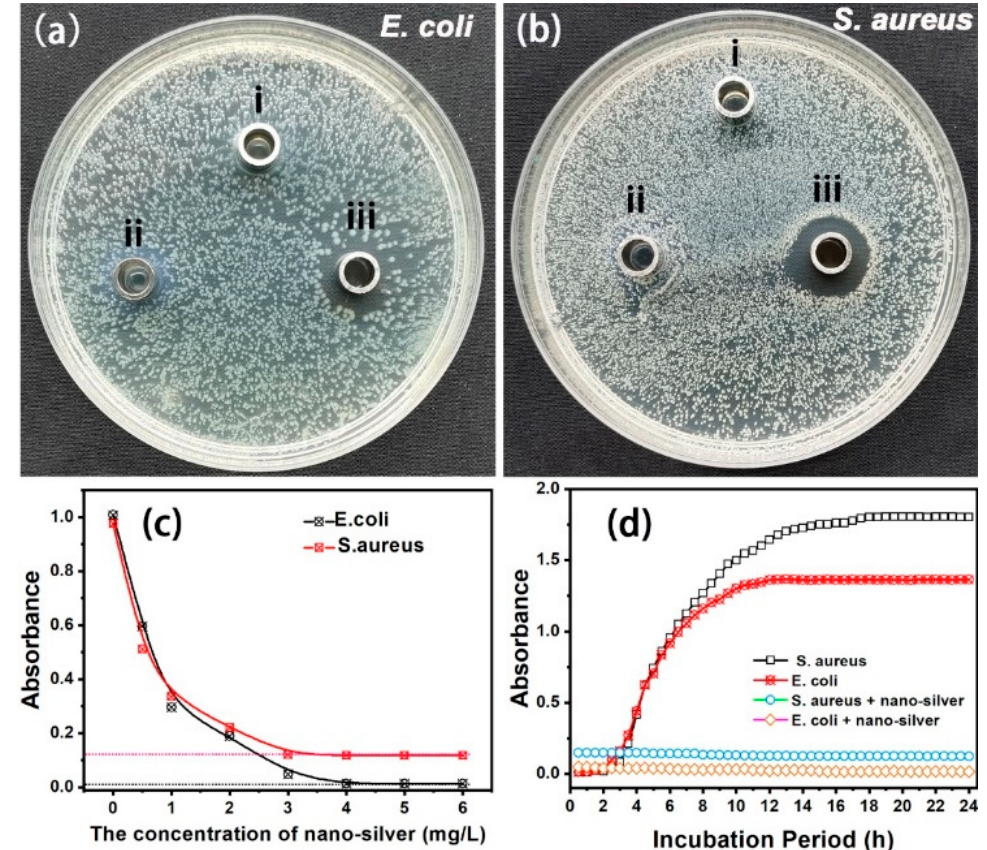
Figure 4. ( a , b ) Inhibition zones of (i) deionized water, (ii) polyurethane, and (iii) nanosilver glue against E. coli and S. aureus (the concentration of nanosilver: 10 mg/L), ( c ) UV–vis absorbance of E. coli and S. aureus suspensions at 546 nm for 6 h incubation as a function of the nanosilver glue concentration, and ( d ) growth kinetics of E. coli and S. aureus in the presence and absence of nanosilver glue (4 mg/L).